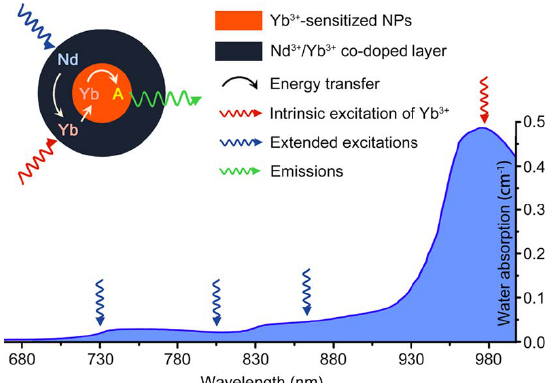
Figure 12. Absorption of water in the NIR and the integration scheme of the Nd 3+ → Yb 3+ energy transfer (ET) process by introducing the Nd 3+ /Yb 3+ co-doped shell. The resulting Nd 3+ → Yb 3+ → activator ET could extend the effective excitation bands for conventional Yb 3+ -sensitized UCNPs. Featuring lower water absorptions, these alternative excitation bands are expected to minimize the tissue overheating effect caused by NIR laser exposure (the blue line represents the absorption spectrum of water). Adapted with permission